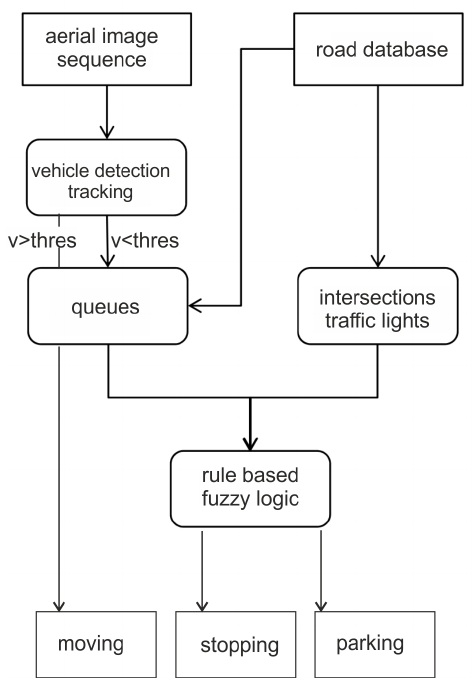
Figure 1. Workflow for vehicle classification